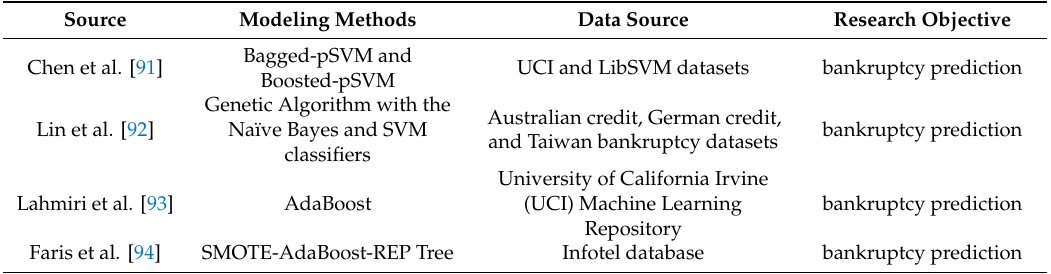
Table 7. Notable machine learning and deep learning methods in corporate bankruptcy